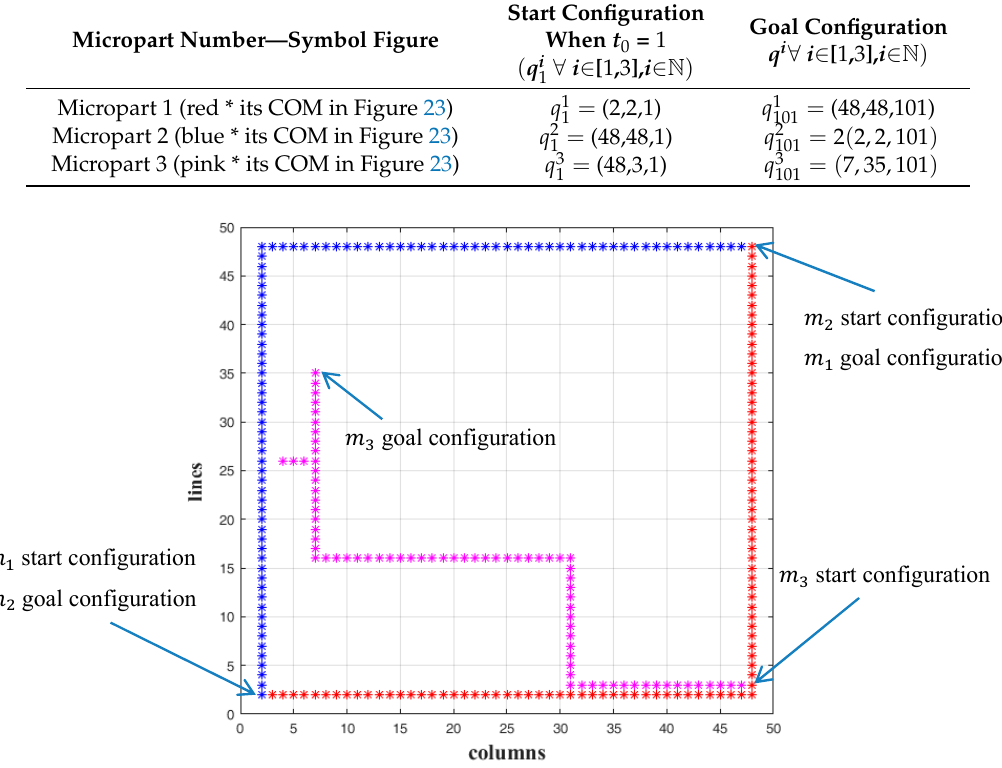
Figure 24. The 2D representation of the path computation of the three microparts with the